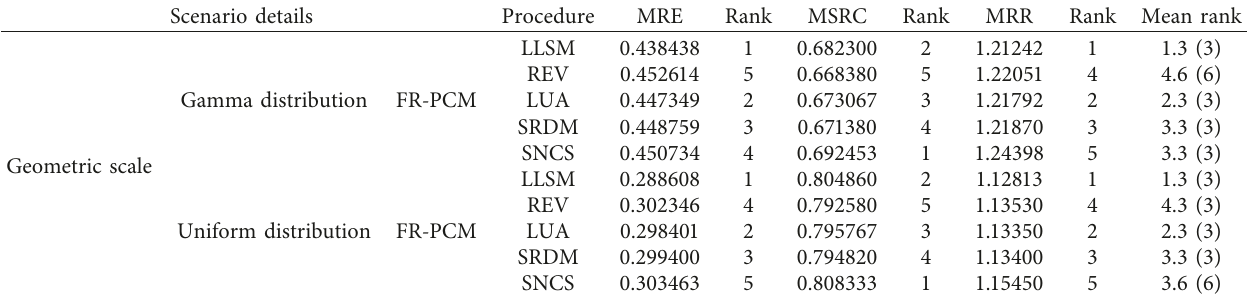
Table 4: Mean performance measures of arbitrarily selected APs for 30,000